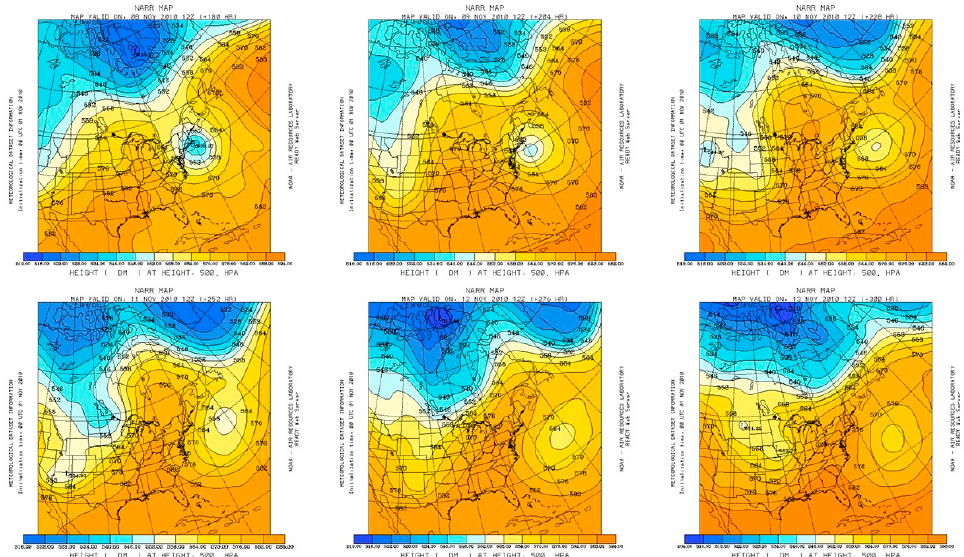
Figure 10. Pattern of 500 hPa GPH from 8 November (upper left) to 13 November (lower right), 2010. Credit: NOAA ARL.